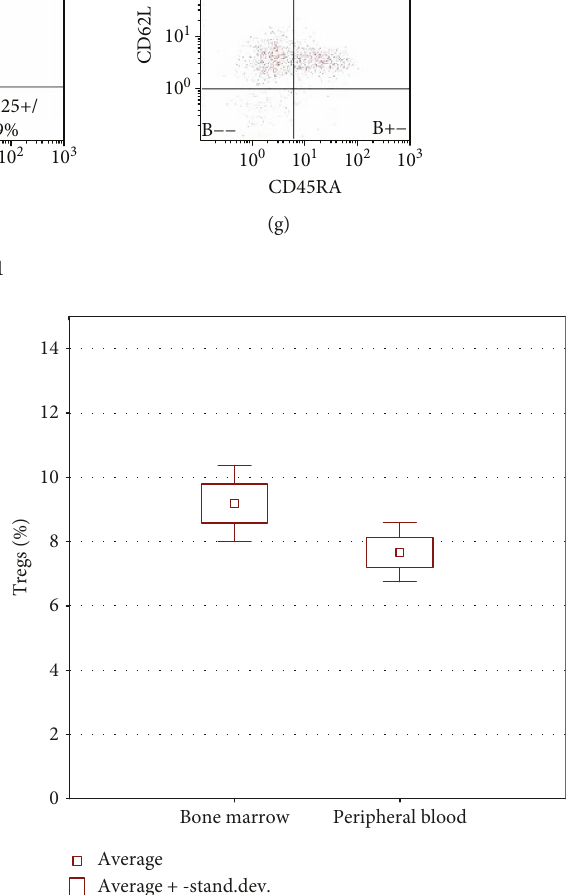
Figure 2: Bone marrow and peripheral blood percentage of Tregs in CD4+ population of cells among children with